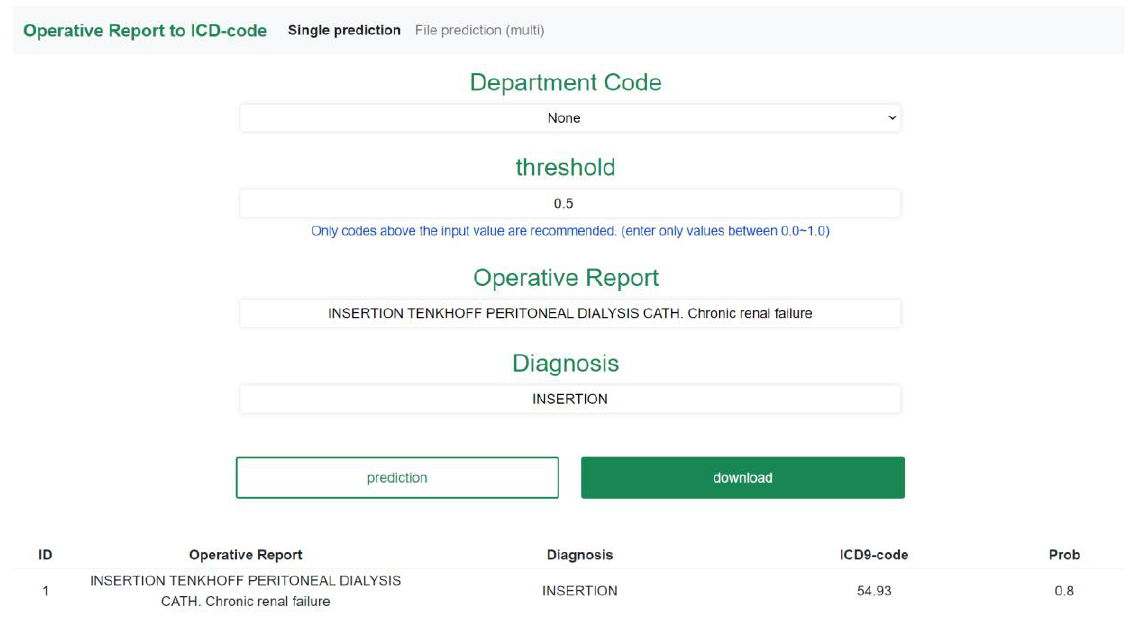
Figure 3. Single prediction page of the web-based application.